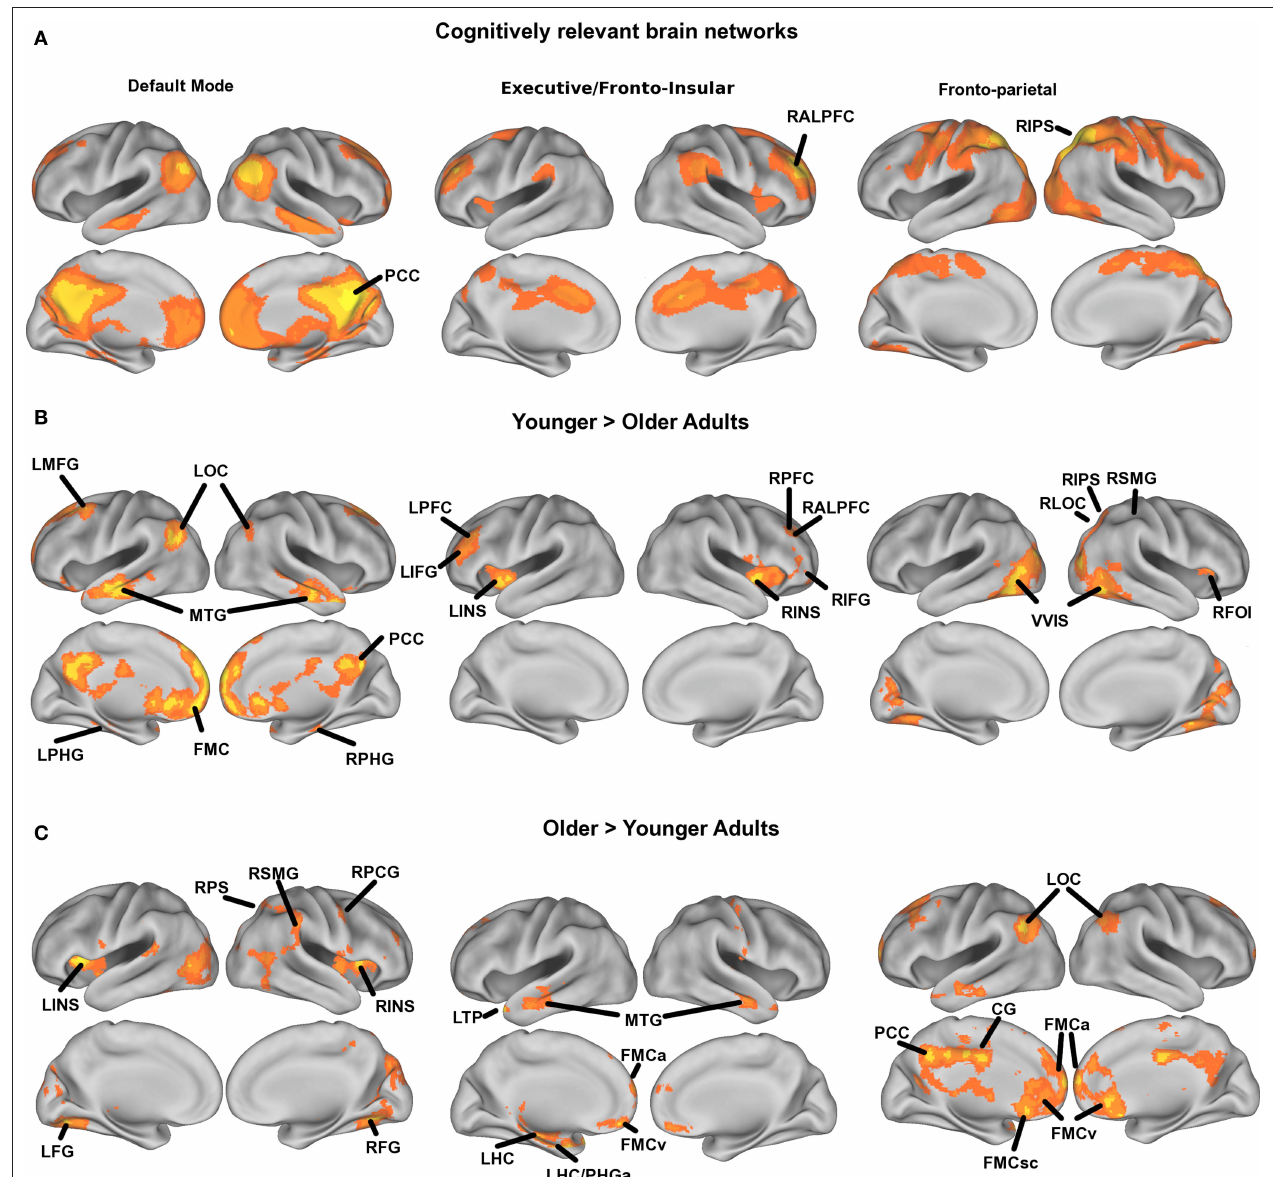
FIguRe 1 | Mean statistical maps for the average of old and young subjects, for cognitive networks, are illustrated in Figure 1A, followed by statistical maps for the contrasts of Young > Old and Old > Young in Figures 1B and 1c,